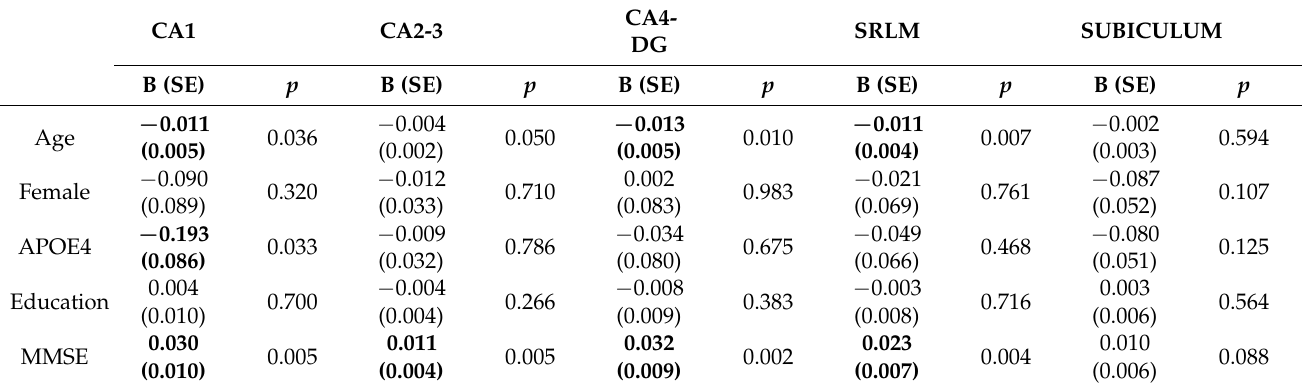
Table 3. Effects of the risks of Alzheimer’s disease on the hippocampal subfield